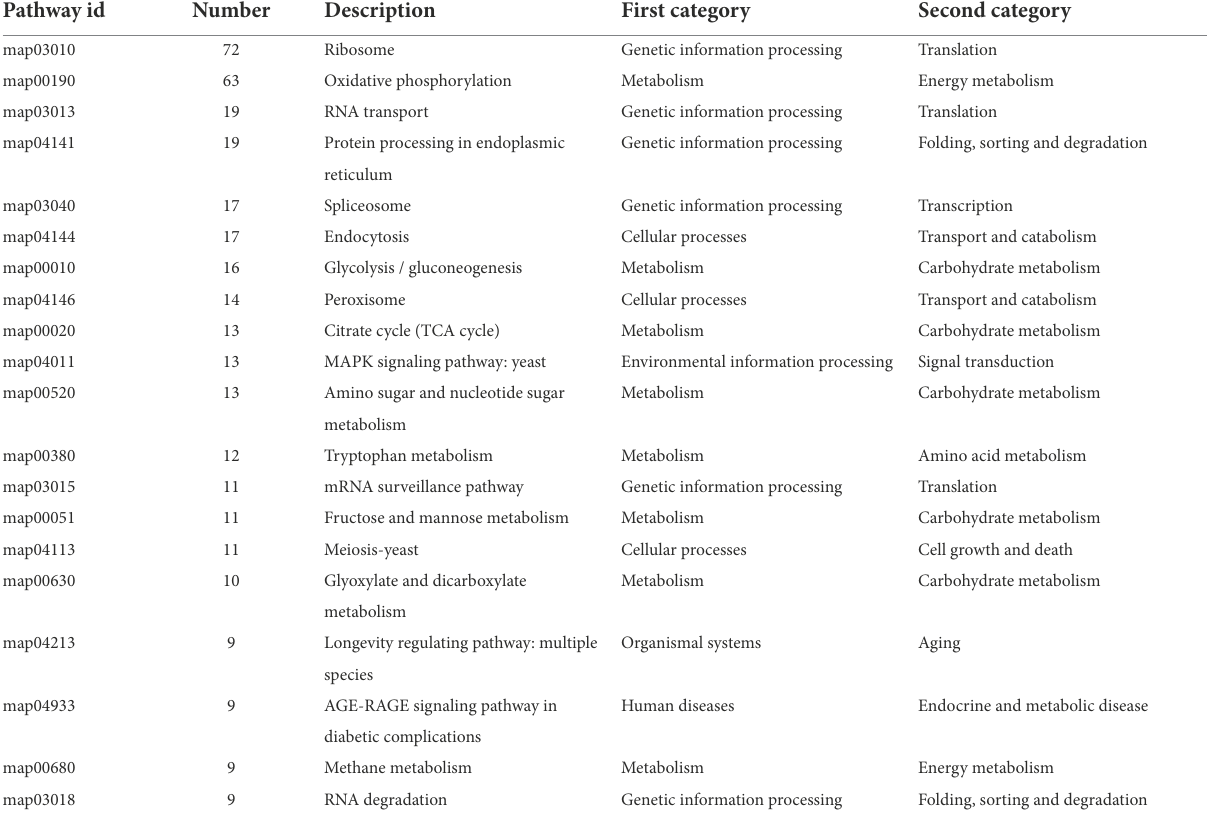
TABLE 2 The 20 most significant pathways and numbers of DEGs. Pathway